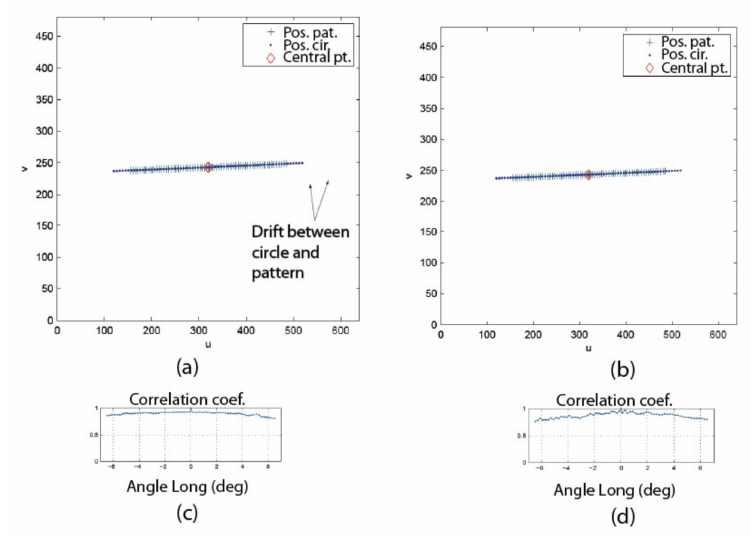
Figure 21. Position of the pattern and the circle observed when the camera of the left ( a ) and right ( b ) eyes rotate around their longitudinal axis. Value of the correlation coefficient for speckle pattern detection for the left eye ( c ) and right ( d ) eye.